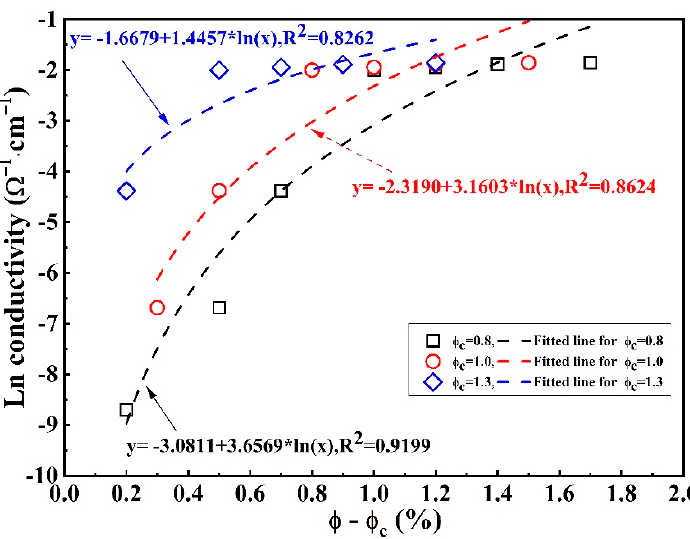
φφ− for graphene/cement composites with di ff erent c